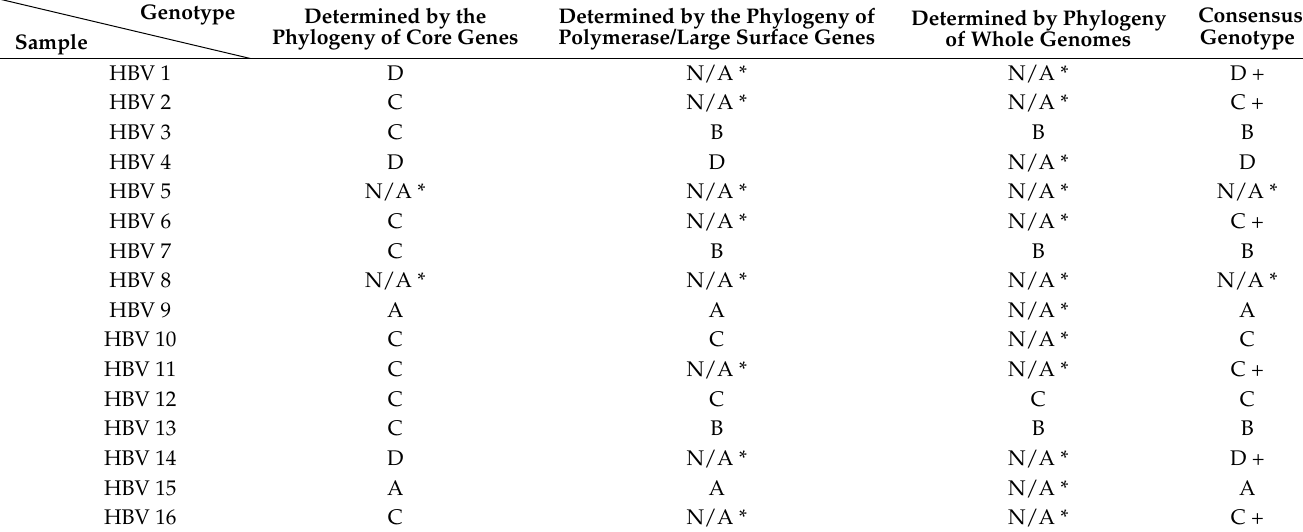
Table 2. HBV genotypes of study samples determined by phylogenetic analysis.